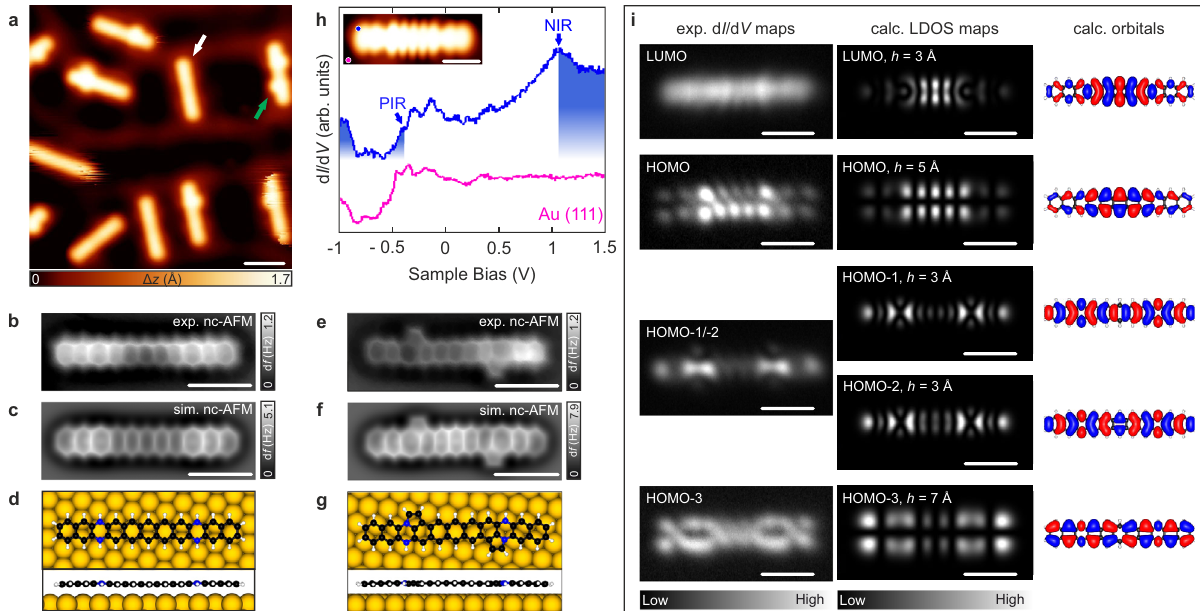
Fig. 3 On-surface synthesis of the hydrogenated tetraazaundecacene 1 and the analog with edge-fused fi ve-membered rings 2 by annealing the sample at 280 °C. a Overview STM topography image of the surface after annealing, showing multiple linear uniform species (one highlighted by the white arrow) and species with laterally extending features near one or both (highlighted by green arrow) of the nitrogen sites. V b = − 0.2 V, I t = 70 pA, scale bar: 2 nm. Δ z denotes the relative height w.r.t. clean Au(111) surface. b , e Constant-height frequency-shift nc-AFM images of the two highlighted cases acquired with a CO-functionalized tip ( z offset − 25 pm below STM set point: 5 mV, 30 pA), scale bar: 1 nm. c , f Simulated nc-AFM images for 1 and 2 based on the DFT equilibrium geometry. d , g DFT equilibrium adsorption geometry of 1 and 2 on Au(111). h d I /d V spectrum acquired on 1 at the position indicated by the blue dot in the inset (inset shows an STM image with V b = − 0.4 V, I t = 40 pA, scale bar: 1 nm). PIR and NIR stand for positive and negative ion resonance, respectively. Reference d I /d V spectrum taken on the bare Au(111) surface is depicted in pink. i Constant-height differential conductance (d I /d V ) maps acquired at bias voltages 1.00, − 0.45, − 0.80, − 1.20 V ( fi rst column; from top to bottom) together with the corresponding DFT-calculated LDOS maps (second column) and corresponding molecular orbital isosurfaces at isovalues ±0.01 a.u. (atomic units; third column). Scale bars: 1 nm. The experimental maps are assigned to molecular orbitals based on the matching with calculated